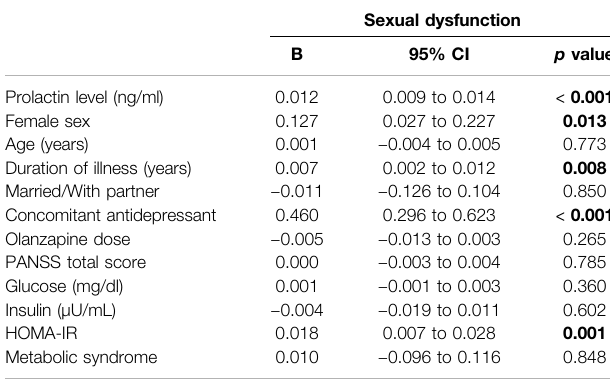
TABLE 4 | Multiple linear regression analysis with sexual dysfunction as dependent